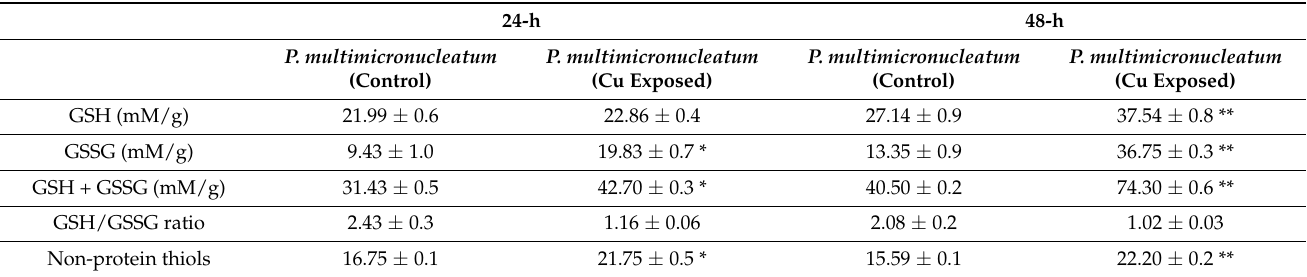
Table 1. Change in GSH and other non-protein thiol content in control and copper-exposed P. multimicronucleatum culture after 24 and 48 h. 24 ‐ h 48 ‐ h